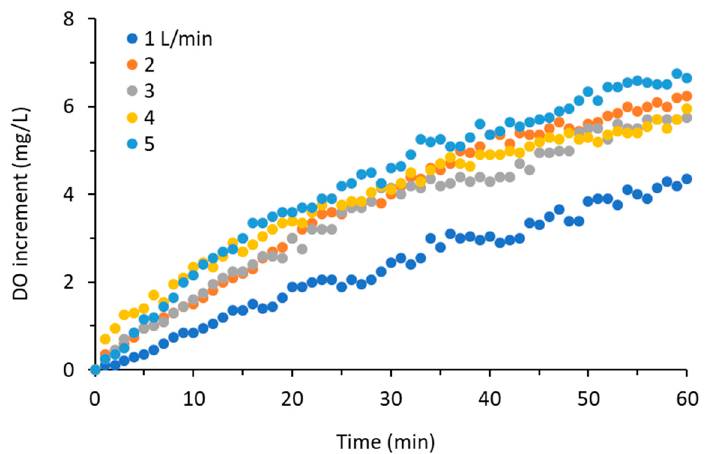
Figure 7. Effect of air velocity on dissolved oxygen (DO) increment against time at fixed liquid velocity of 2.46 m/s. The DO increment is presented as relative to the initial DO reading of about 2 mg/L.